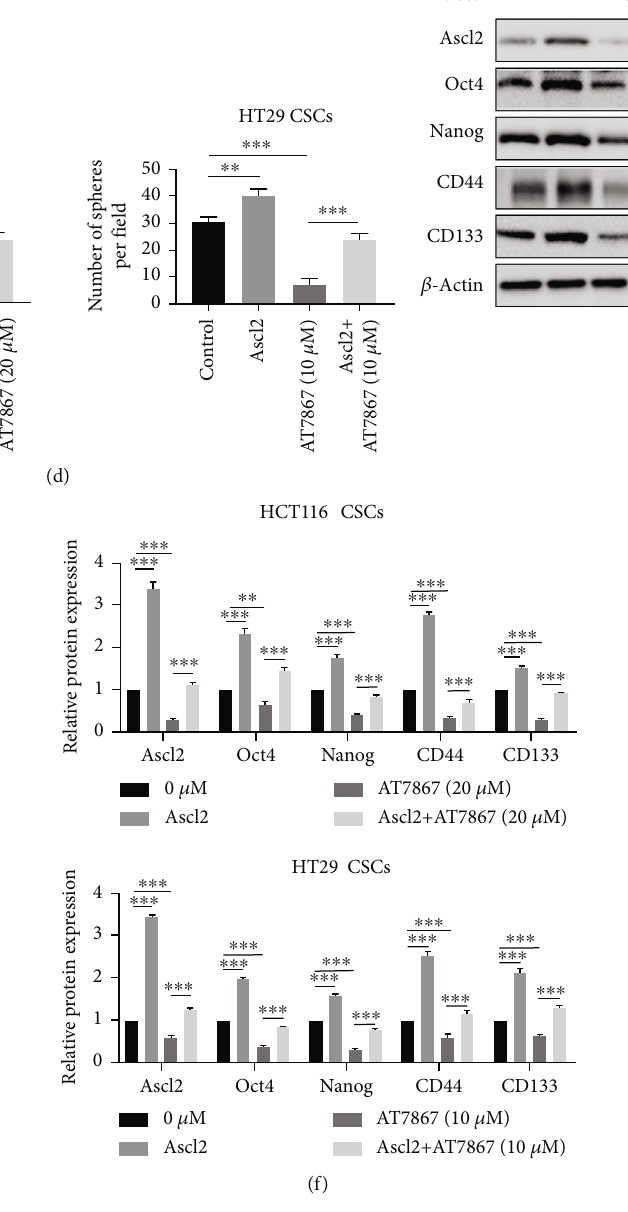
Figure 6: AT7867 regulates CSC stemness expression by inhibiting Ascl2. (a, b) Western blot detected the parental cells, the fi fth spheres, and treatment of the fi fth spheres in a di ff erent dose of AT7867 expression of Ascl2. CSCs were transfected with Ascl2 vector and then treated with AT7867. (c, d) Representative morphology after AT7867 treatment (sphere formation assay) or pretreatment (sphere recovery assay). (e, f) the expression of Ascl2, Oct4, CD44, and CD133 were detected by western blotting. ∗ P < 0 : 05 , ∗∗ P < 0 : 01 , and ∗∗∗ P < 0 : 001